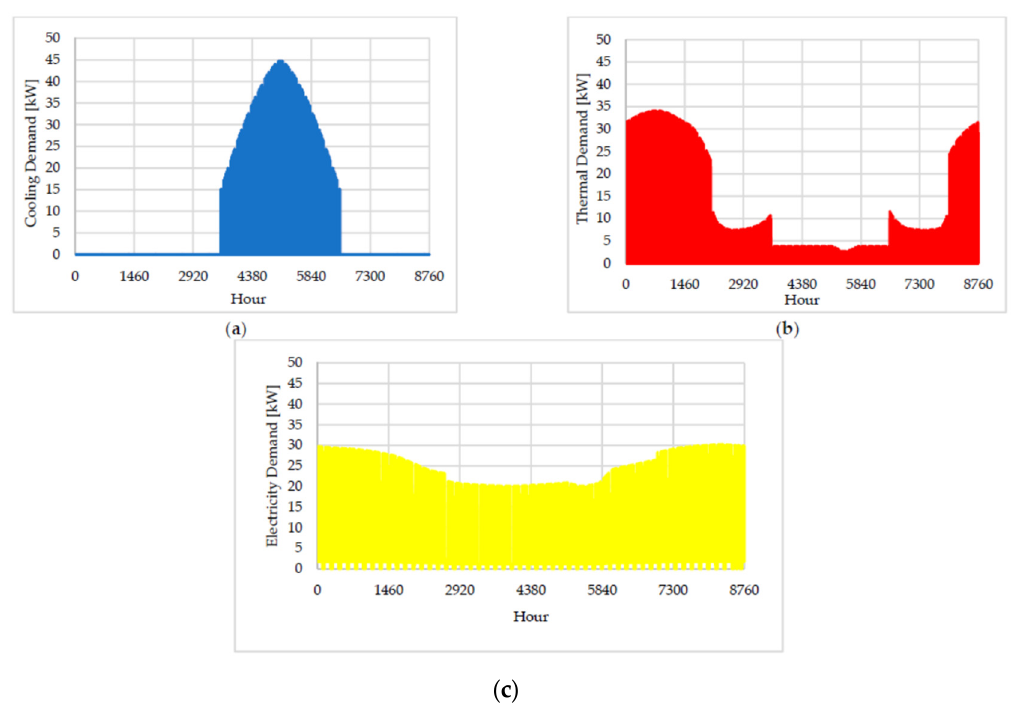
Figure 2 . Hourly profiles of the case study: ( a ) cooling, ( b ) thermal, and ( c ) electricity demands [15]